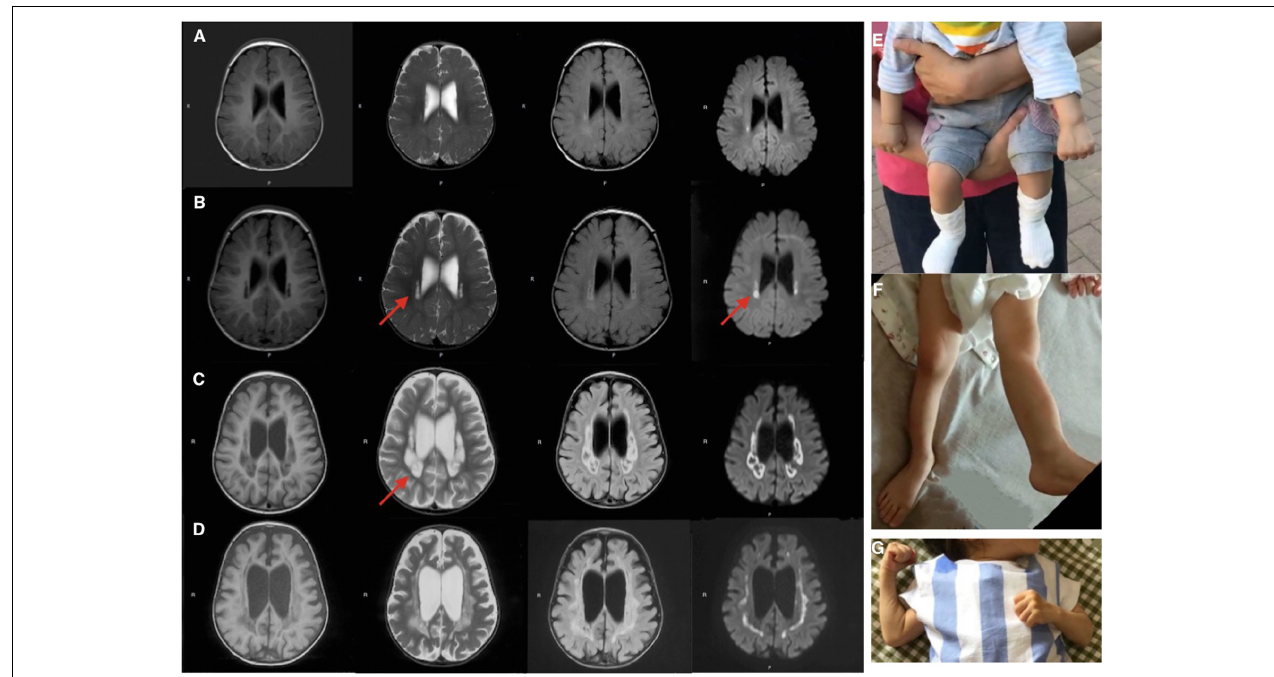
FIGURE 1 | Brain MRI (T1-weighed) showing progressive brain atrophy. MRIs of the patient taken at (A) 9, (B) 11, (C) 16, and (D) 21 months of age. Note the high T2 signal in the periventricular regions on restriction diffusion weighed images (B,C) . (E,F) Progressive muscular hypertonia at 11 and 16 months old. (G) Partially controlled hypertonia after baclofen treatment at 2 years